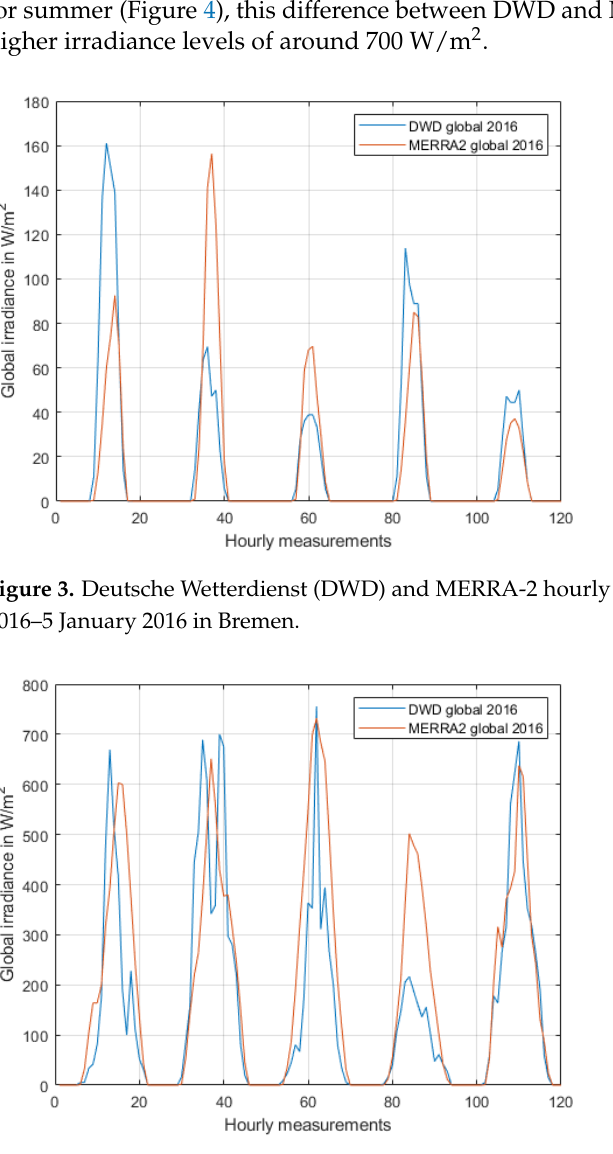
Figure 4. DWD and MERRA-2 hourly global irradiance (GI) for 1 August 2016–5 August 2016 in